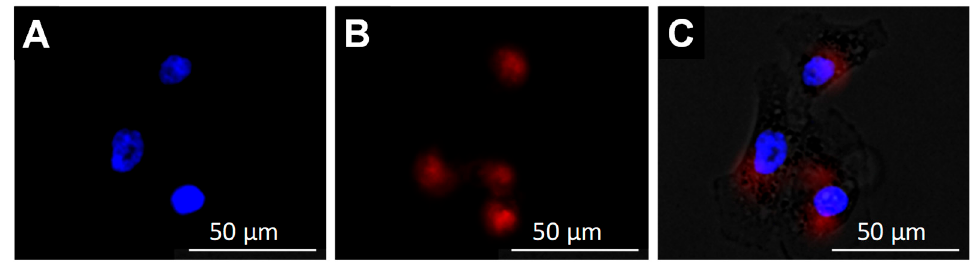
8 of 14 Figure 4. Viability of human prostate cancer DU145 cells ( A ) and human embryonic kidney HEK-293